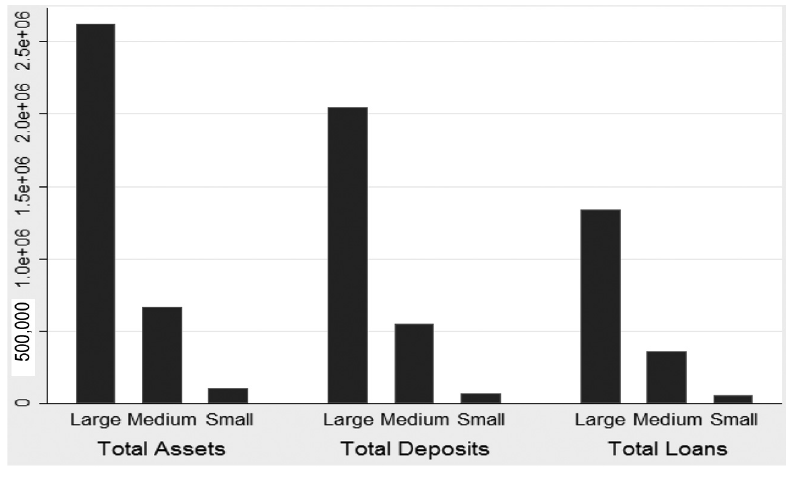
Figure 1. Mean values of banking selected variables by